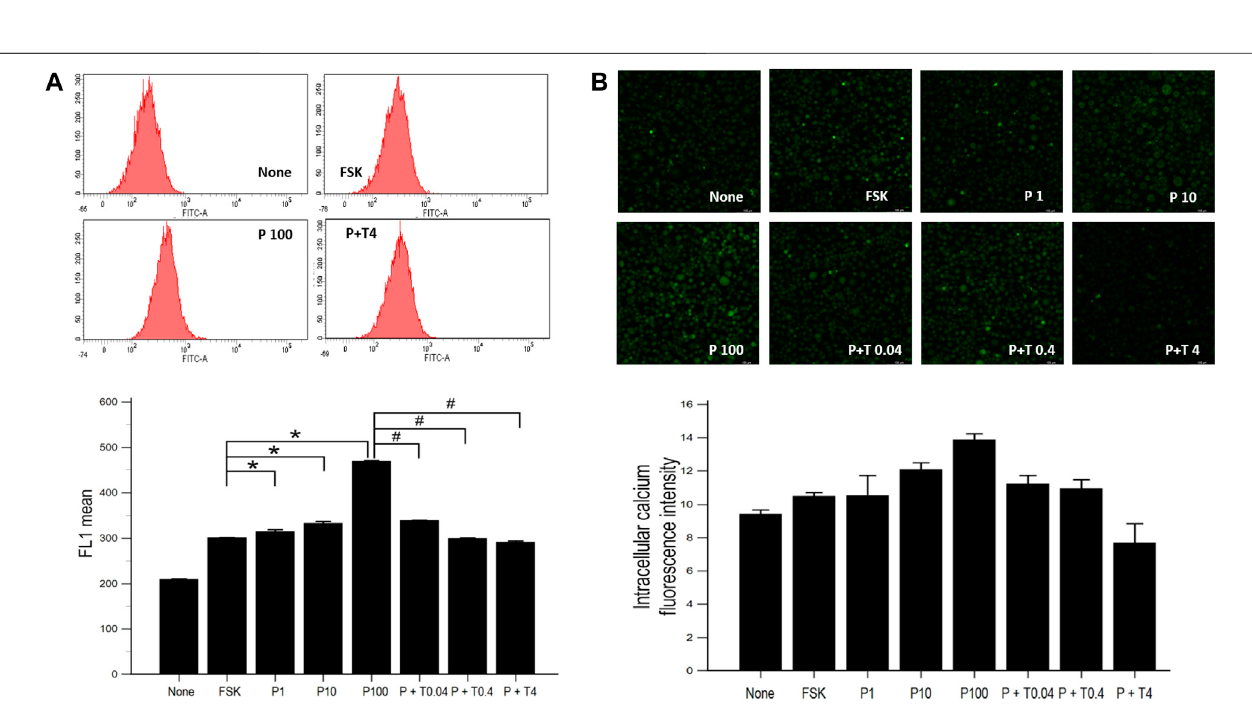
FIGURE3| Calciumin fl uxin50B11cells.IntracellularcalciumlevelswereevaluatedinFSK-derivedneuronsunderserum-freeconditions. (A) Histogramsfrom fl ow cytometry analysis. The stained cell population and mean fl uorescence intensity in FL1 were quanti fi ed and compared among undifferentiated cells, differentiated cells, PAC treated differentiated cells, and PAC with TMI-1 treated differentiated cells ( n = 3 per group). (B) Calcium-stained cells were green under the confocal microscope ( n =2pergroup).Dataarepresented asthemedianandinterquartilerange(IQR)andanalyzedusingtheKruskal-WallistestfollowedbytheConover test.* p < 0.05 compared to the FSK; # p < 0.05 compared to the